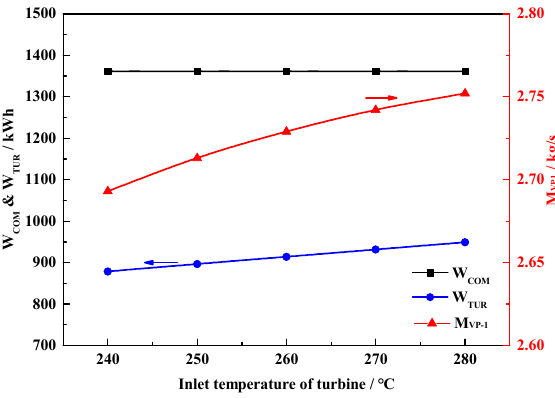
Figure 7. Effect of air turbine inlet temperature on W COM , W TUR , and VP-1 mass flow.